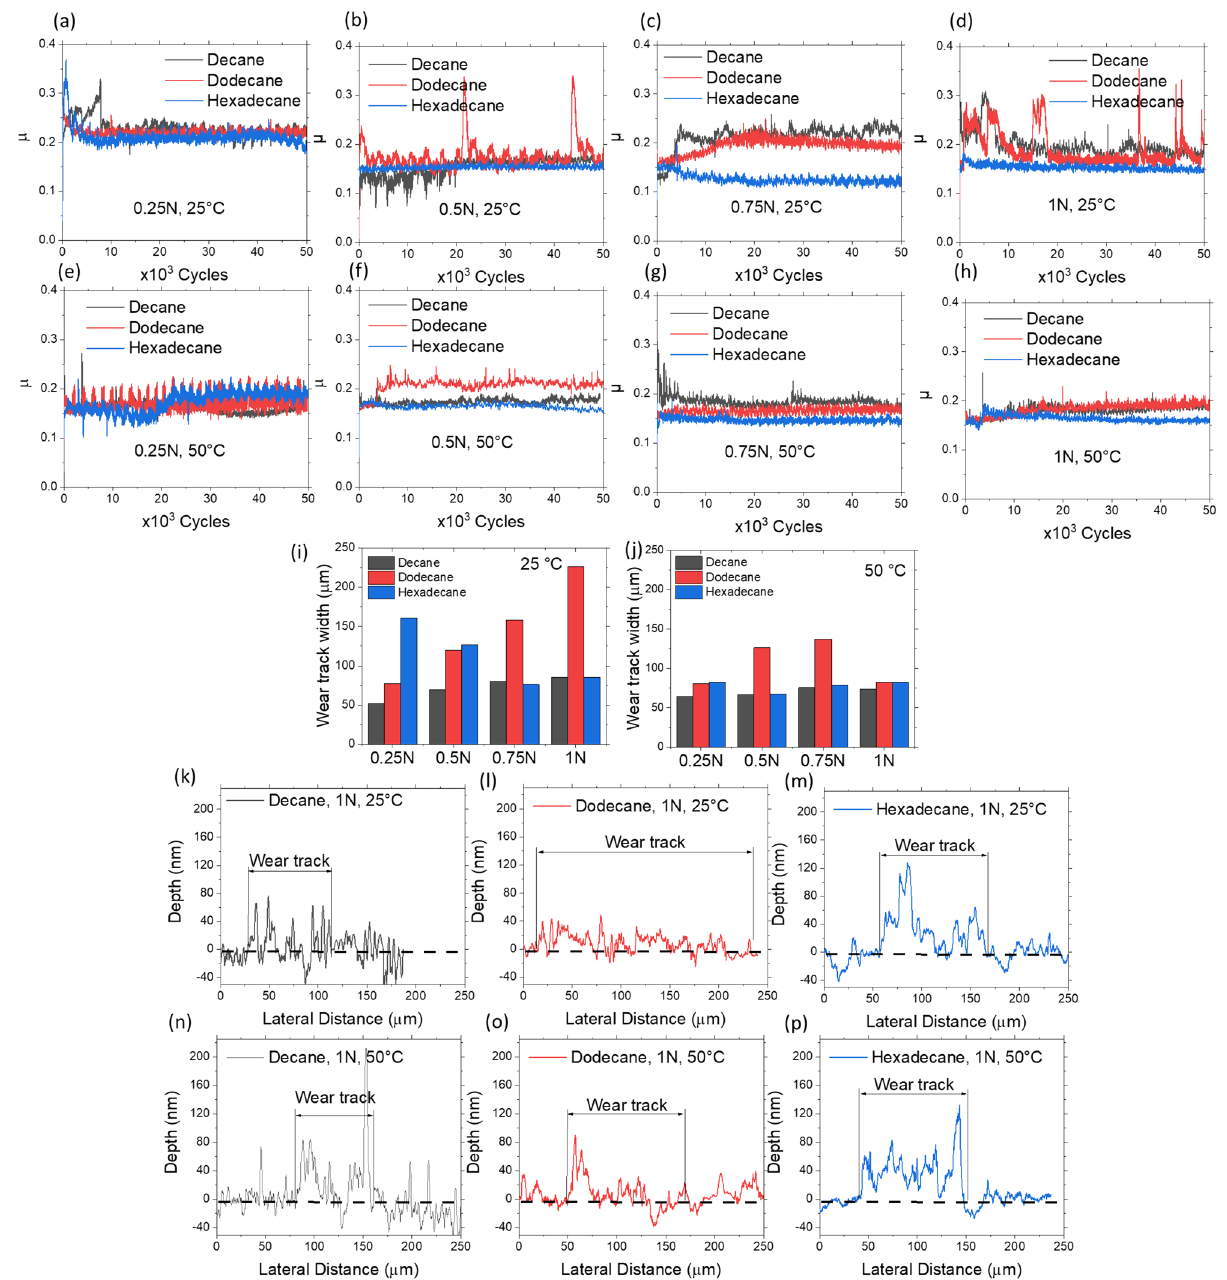
Figure 4. Coefficient of friction behavior of the MoN-Cu coating tribologically tested in decane, dodecane, and hexadecane at 25 and 50 °C at applied loads of ( a , e ) 0.25 N, (b, f) 0.5 N, ( c , g ) 0.75 N, and ( d , h ) 1 N, respectively. Width of the wear tracks formed on MoN-Cu coatings at ( i ) 25 °C and ( j ) 50 °C as load progresses within the 0.25–1 N range. Stylus profilometry results showing film formation in the wear track during the tribology tests in decane ( k , n ), dodecane ( l , o ), and hexadecane ( m , p ) at 25 °C, and 50 °C,